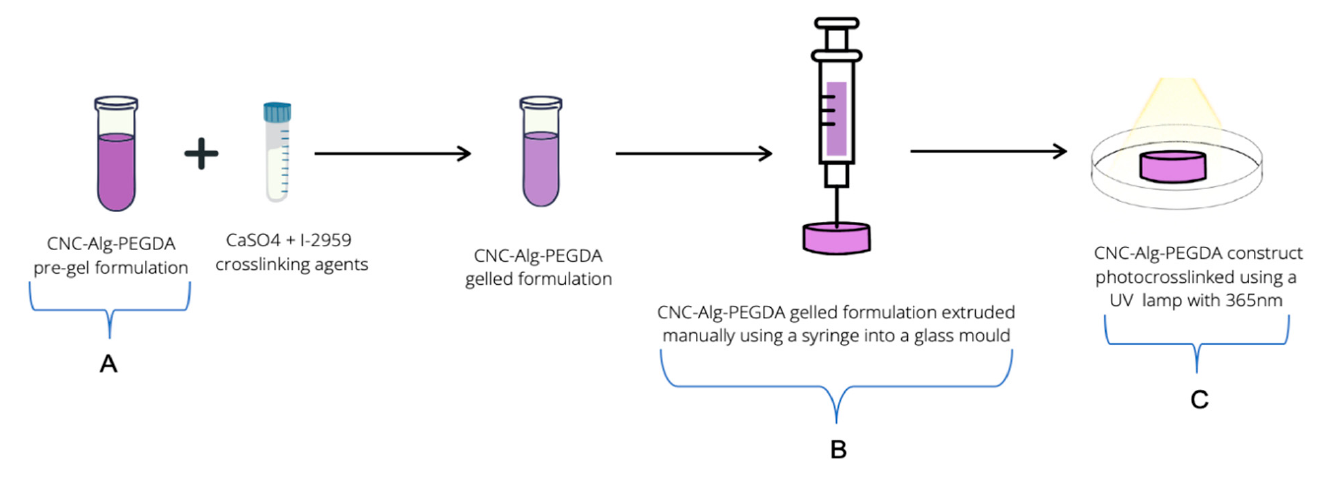
Figure 2. Schematic illustration of the manual extrusion process of CNC/Alg/PEGDA formulations. The important process includes ( A ) pre-gel formulation preparation, ( B ) extrusion of hydrogel into a glass mould, and ( C ) construct treated with UV irradiation at 365 nm post extrusion.